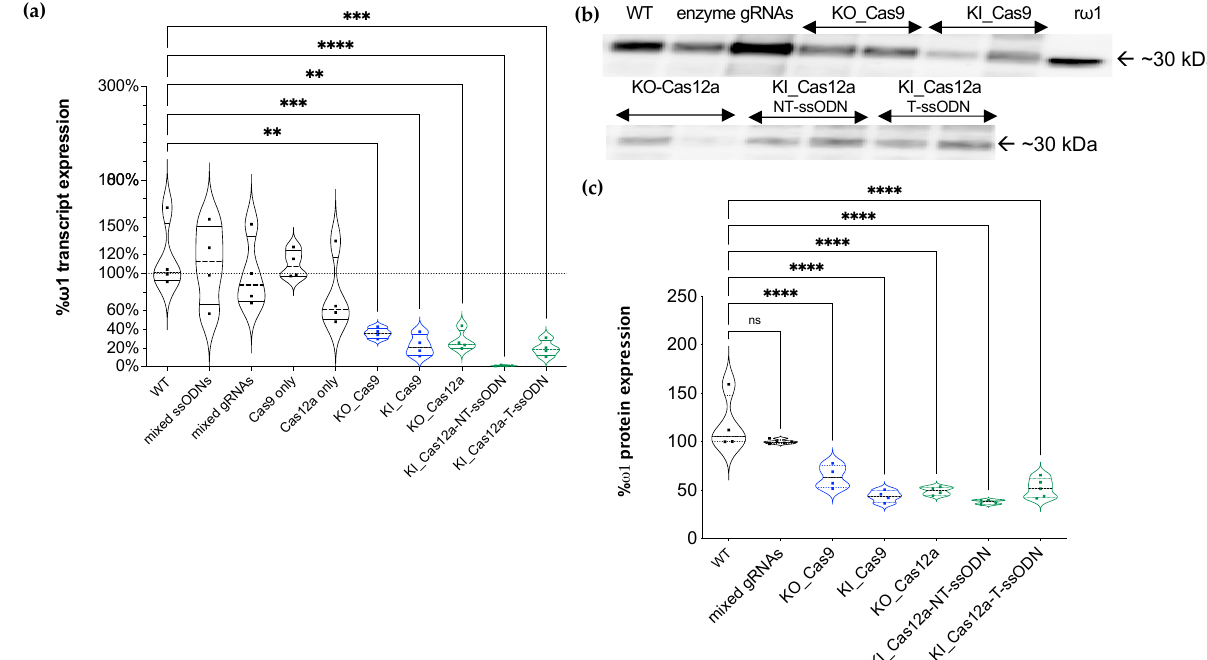
Figure 5. Reduction of the expression of ω 1 as assessed by quantitative real-time PCR and im- munoblot analysis; ( a ) Reduction of ω 1 transcript levels from KO_Cas9 (blue dots), KI_Cas9 (blue dots), KO_Cas12a (green dots), KI_Cas12a_NT-ssODN (green dots), and KI_Cas12a_T-ssODN eggs (green dots) compared with control groups (black dots) after normalization with wild type (WT) egg RNA (100% as discontinued line). The means represent four independent biological replicates; ( b , c ) Soluble egg antigen; SEA (in duplicates) was sized in SDS-PAGE gels, transferred to PVDF, and probed with anti-recombinant omega-1 (r ω 1) rabbit IgG. Levels of ω 1 protein, migrating at 30 kDa, were reduced in all treatment groups. The percentage of ω 1 expression in both KO and KI exper-imental groups were compared to ω 1 levels in WT SEA (100%) (one-way ANOVA, multiple comparison, **, p ≤ 0.01, ***, p ≤ 0.001, ****, p ≤ 0.0001; ‘ns’ indicates not statistically